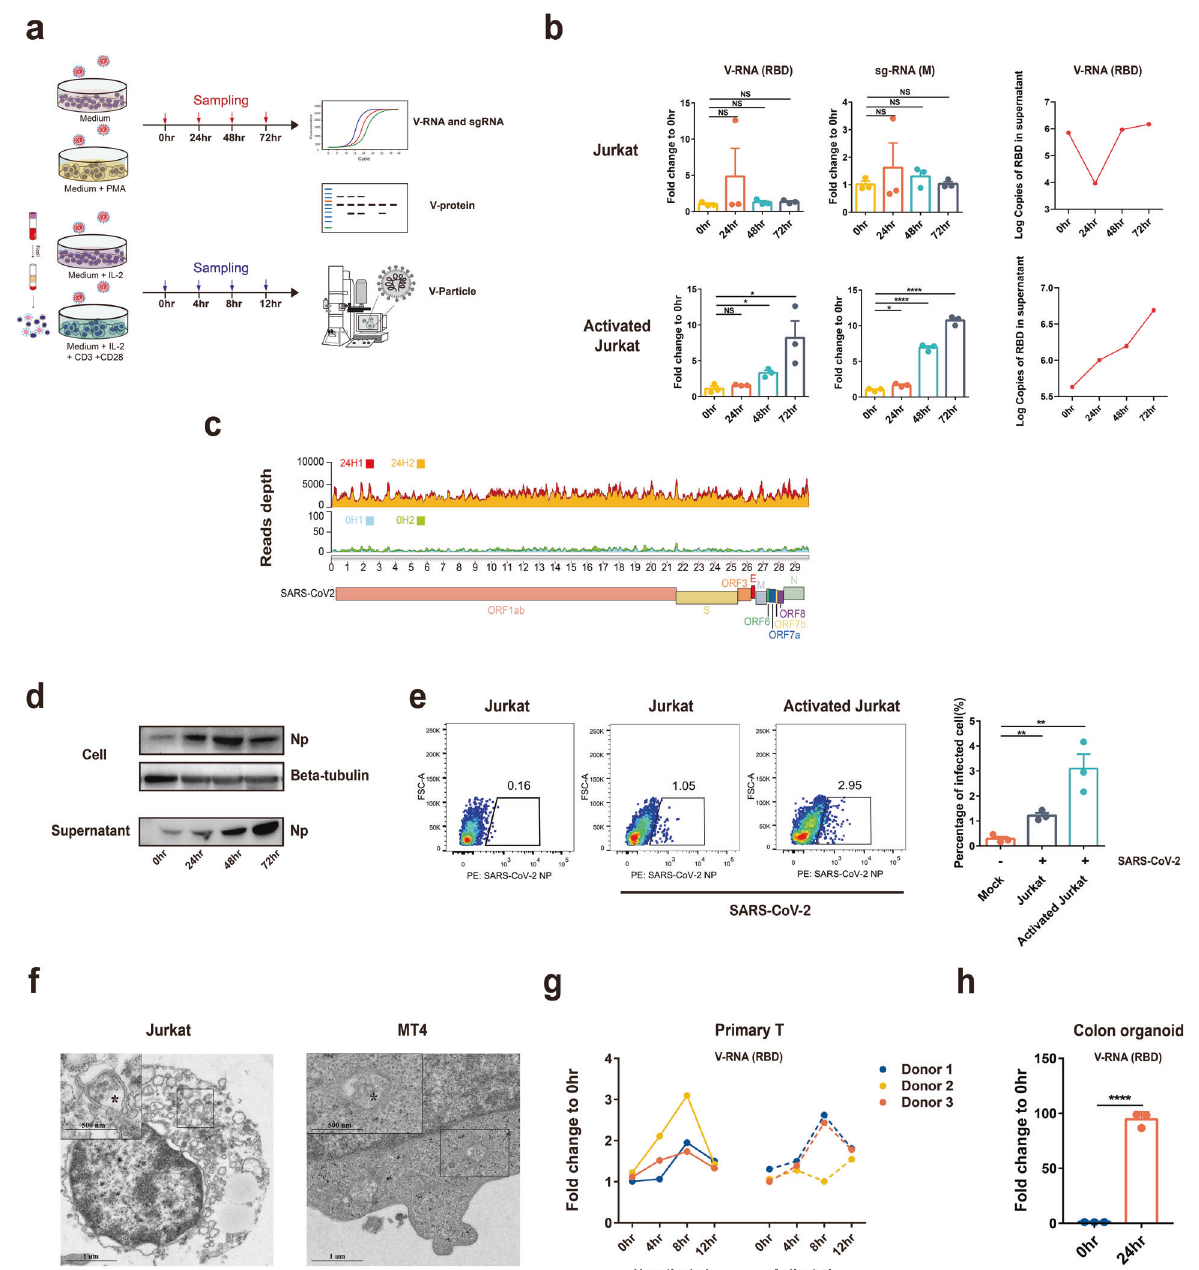
Fig. 2 SARS-CoV-2 in vitro infection of T cell lines or primary T cells. a Schedule of experiments. b Unactivated or activated Jurkat cells were infected with SARS-CoV-2 (MOI = 0.1) and samples were collected at 0, 24, 48, and 72 h post infection. Viral load in cells or cell supernatant was then quanti fi ed by qPCR detection of total viral RNA (RBD of spike gene as target) or subgenomic RNA (sgRNA, M gene as target). c Depth and coverage comparison for SARS-CoV-2 0 h or 24 h-infected activated Jurkat cells. For each sample, virus quantity was normalized with its total reads number of sequencing. Two replicates are shown for each time point. d Viral NP in the infected activated Jurkat cells and cell supernatant was analyzed by western blot at 0, 24, 48, and 72 h post infection. e Viral NP 72 h-infected cells from ( d ) were analyzed by fl ow cytometry and the number of replicates that are represented in the bar graph is three. f Viral particles in infected activated Jurkat or MT4 cells were observed by transmission electron microscope. bar = 1 μ m or 500 nm, magni fi cation: 3500-folds and 9600-folds for Jurkat cell, 5000-folds or 11500-folds for MT4 cell. g Unactivated or activated primary T cells were infected with SARS-CoV-2 (MOI = 0.01) and samples were collected at 0, 4, 8, and 12 h post infection. Viral load in cells was then quanti fi ed by qPCR. h Colon organoids were infected with SARS-CoV-2 (MOI = 0.01). Zero hour and 24 h samples were harvested and quanti fi ed by qPCR. The data were analyzed by Student ’ s t test and statistical signi fi cance is indicated by the asterisks (* P < 0.05; ** P < 0.01; **** P < 0.0001; NS no signi fi